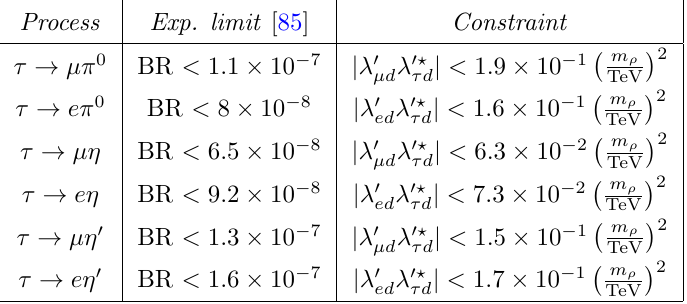
Table 18 . Constraints on couplings and the LQ mass from semileptonic tau decays in the triplet LQ case. Here we have assumed all the triplet (cid:12)elds ((cid:22) (cid:26) 4 = 3 , (cid:22) rho 1 = 3 , (cid:22) (cid:26) (cid:0) 2 = 3 ) to have the same mass m (cid:26)